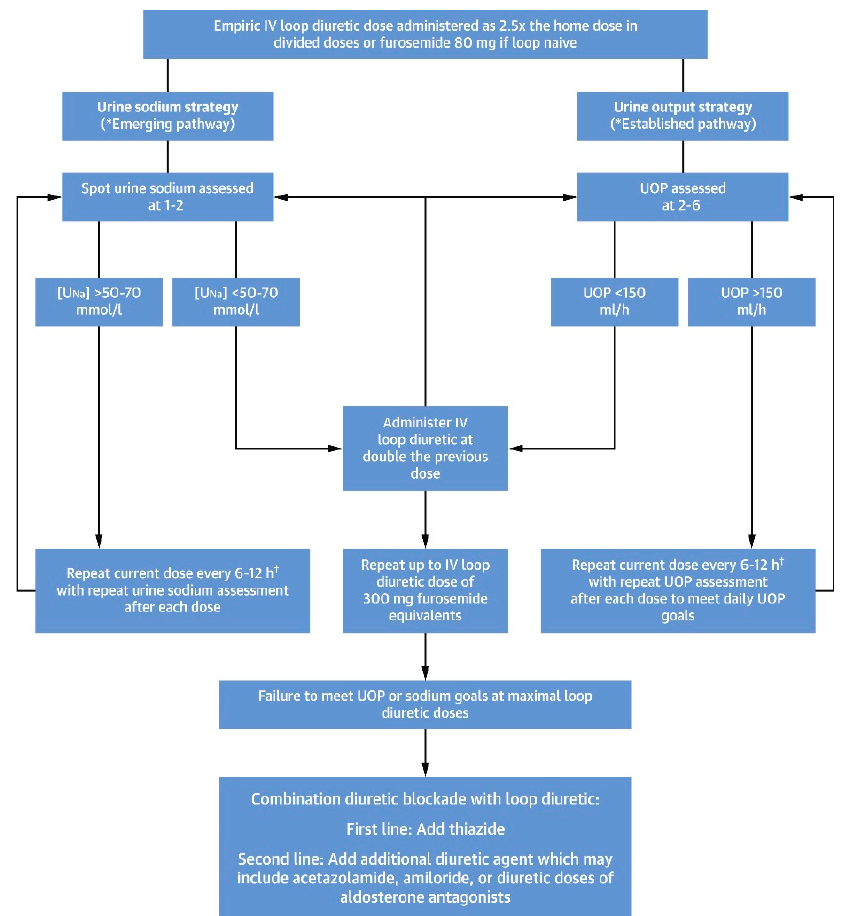
Figure 4. A proposed algorithm for titrating diuretic strategies in patients with persistent congestion and diuretic resistance, on the basis of urine sodium measurement and urine output, is shown. For more details, see [22]. Reprinted with permission from Ref. [22] 2022, Elsevier. †: loop diuretic doses exceeding >1000 mg of furosemide equivalents/day have limited safety data and should be used cautiously. Bumetanide may confer less risk at higher doses because it has demonstrated reduced ototoxicity risk in animal models.